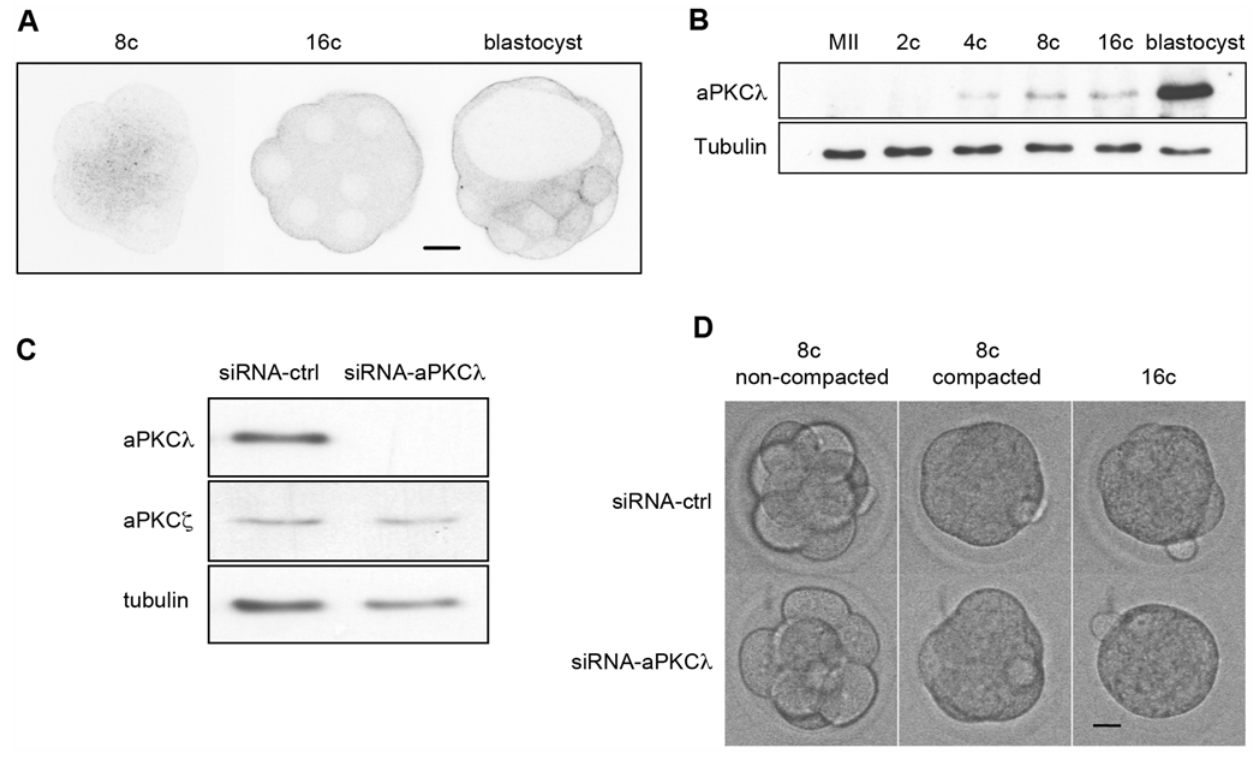
Figure 1. Depletion of aPKC l induces an abnormal morphology at the 16-cell stage. (A): Spinning-disk microscope analysis of aPKC l localization at the 8-cell (10 embryos), 16-cell (26 embryos), and blastocyst (13 embryos) stages. Scale bar: 20 m m. (B): Expression profile of aPKC l protein during preimplantation development. Immunoblot was performed twice on extracts from 50 MII oocytes, 2-cell stage, 4-cell stage, 8-cell stage, 16-cell stage and blastocyst stage embryos. (C): Inhibition of aPKC l expression by RNA interference. Immunoblot performed on blastocyst extracts. Microinjection of control siRNA or siRNA against aPKC l was performed at the 2-cell stage in both blastomeres, and embryos were cultured until the blastocyst stage. 40 blastocysts were used per lane. Detection of aPKC f and tubulin was used as a control for siRNA specificity and a loading control, respectively. Experiments were performed twice with two different siRNA. (D): Snapshots of two living embryos in which control siRNA (siRNA-Ctrl) or siRNA against aPKC l (siRNA-aPKC l ) were microinjected at the 2-cell stage. Pictures of the same embryo were taken at the non- compacted (8c non-compacted) and compacted (8c compacted) 8-cell stage, and at the 16-cell stage (16c). Scale bar: 20 m m.